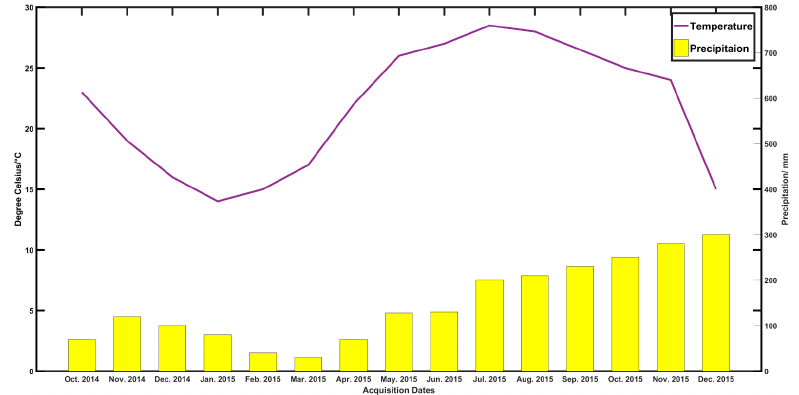
Figure 8. The temperature and precipitation of Fuoshan city (from October 2014 to December 2015).